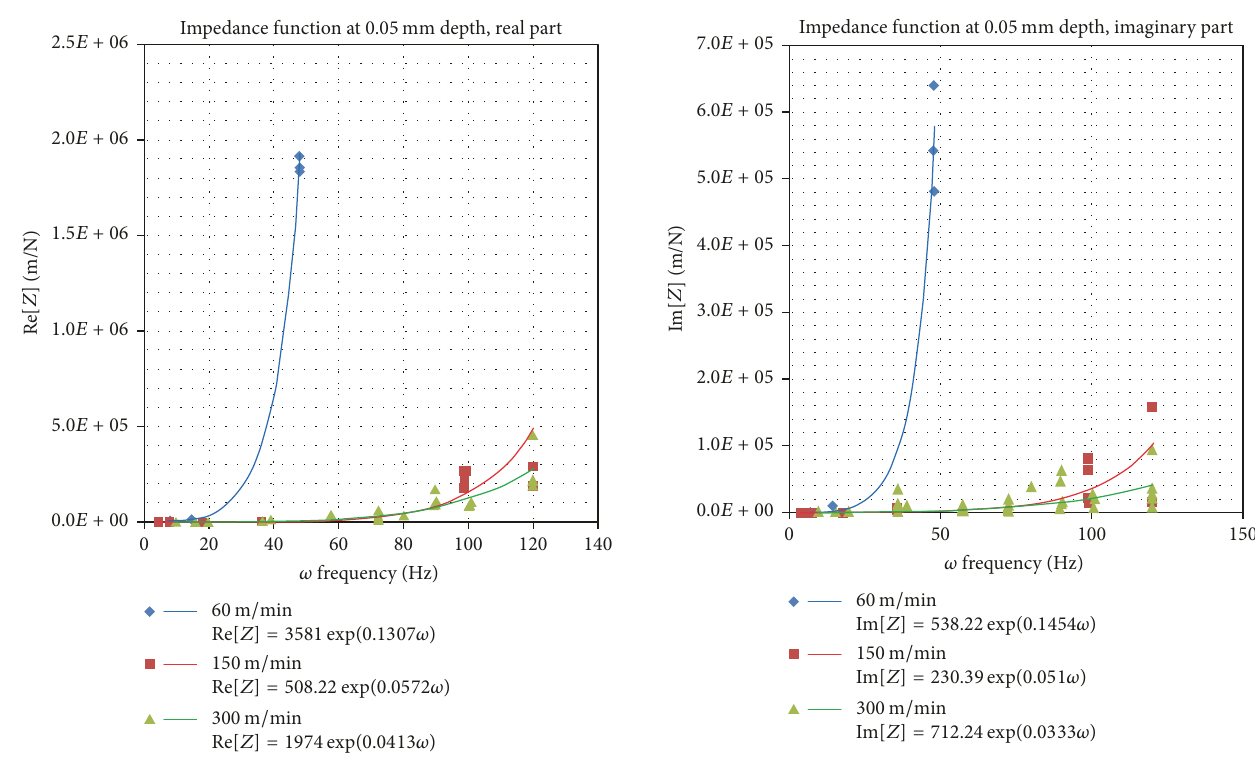
Figure 8: Imaginary part of the impedance function, at 0.05 mm depth of cut, under 60, 150, and 300 m/min of cutting speed.